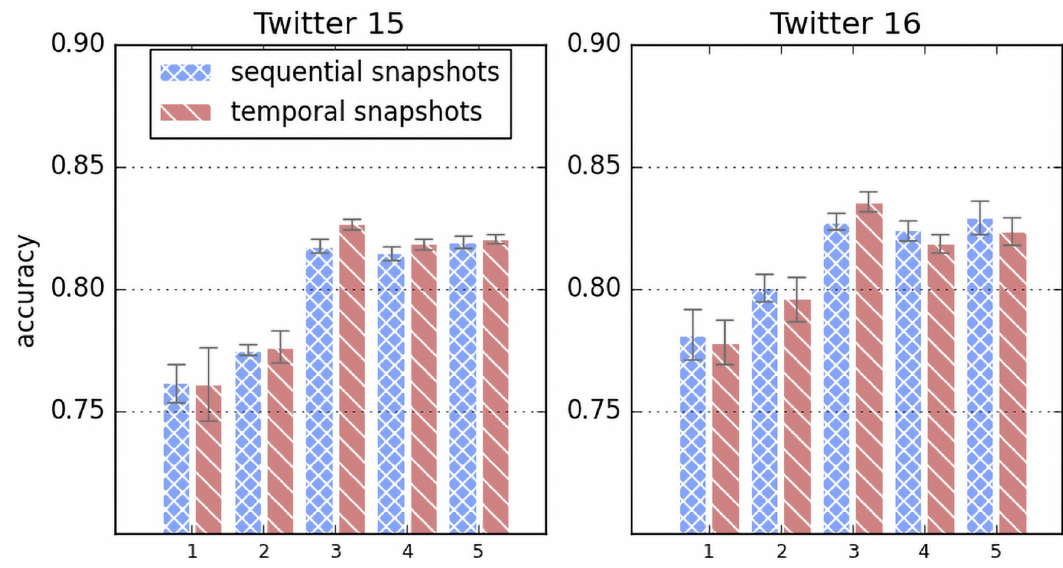
Fig 4. Difference in accuracy for different snapshot counts.